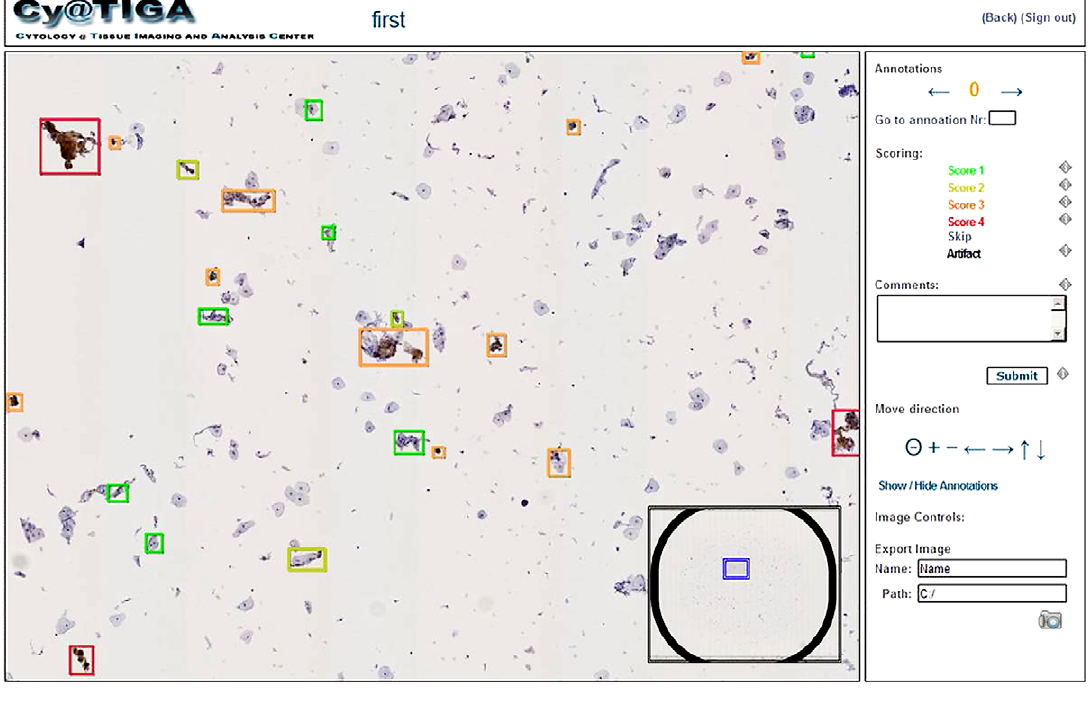
Fig. 1. Web interface of the cytology server application. The web interface allows free panning, zooming and focusing as well as “one click” diagnostic decisions of the computationally pre-screened cytological slide. Instead of an image gallery, the user is walked through the virtual slide via a pre-computed navigation route allowing the evaluation of all objects in their natural spatial context. Each object (cell or cell cluster) can be assigned a score by a single mouse click; free-text comments can be added.